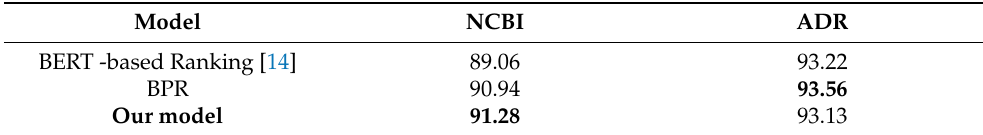
Table 6. Performance comparison with BERT-based methods. Model